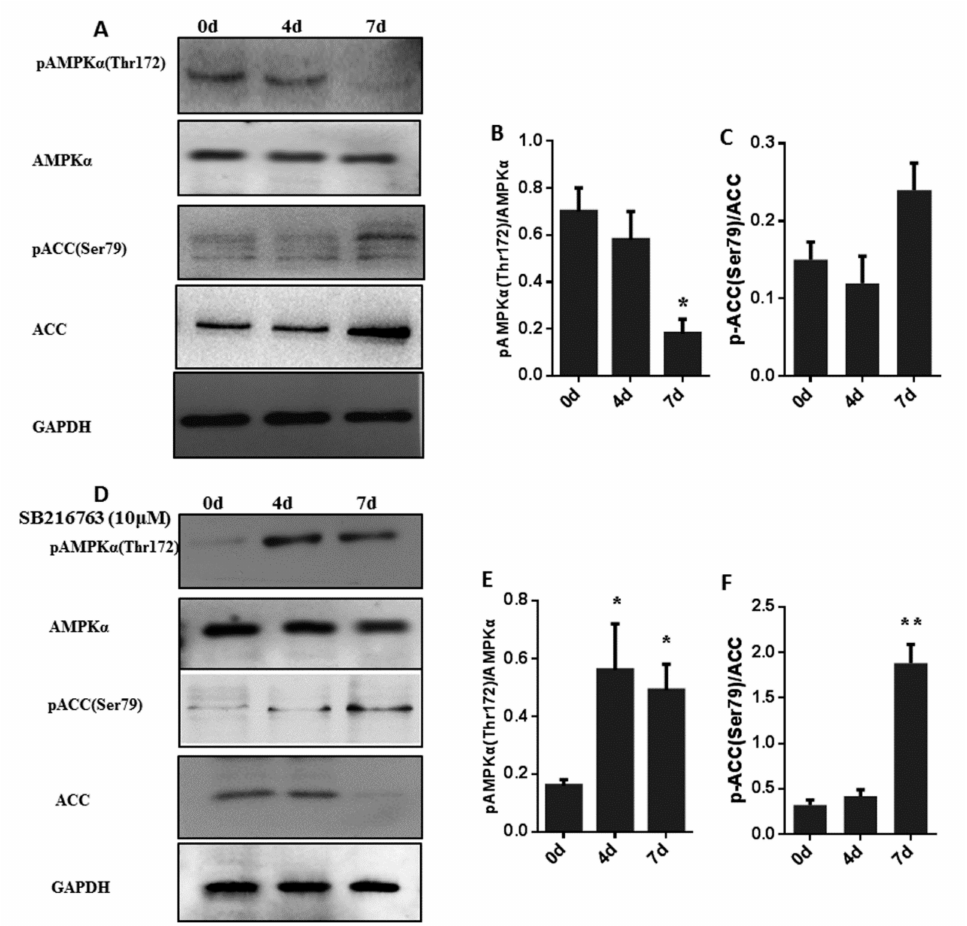
Figure 6. Inhibition of GSK3 β increased the levels of pAMPK α (T172) and pACC (Ser79) in muscle satellite cells. ( A , B , C ) Representative western blots and quantified results of pAMPK α (T172) and pACC (Ser79) during adipogenic di ff erentiation in muscle satellite cells for 0, 4 and 7 days. ( D , E , F ) Representative western blots and quantified results of pAMPK α (T172) and pACC (Ser79) in muscle satellite cells treated with SB216763 for 0, 4 and 7 days after adipogenic di ff erentiation. Error bars represent the SEMs of three separate experiments. ** p < 0.01; * p < 0.05 relative to 0 d